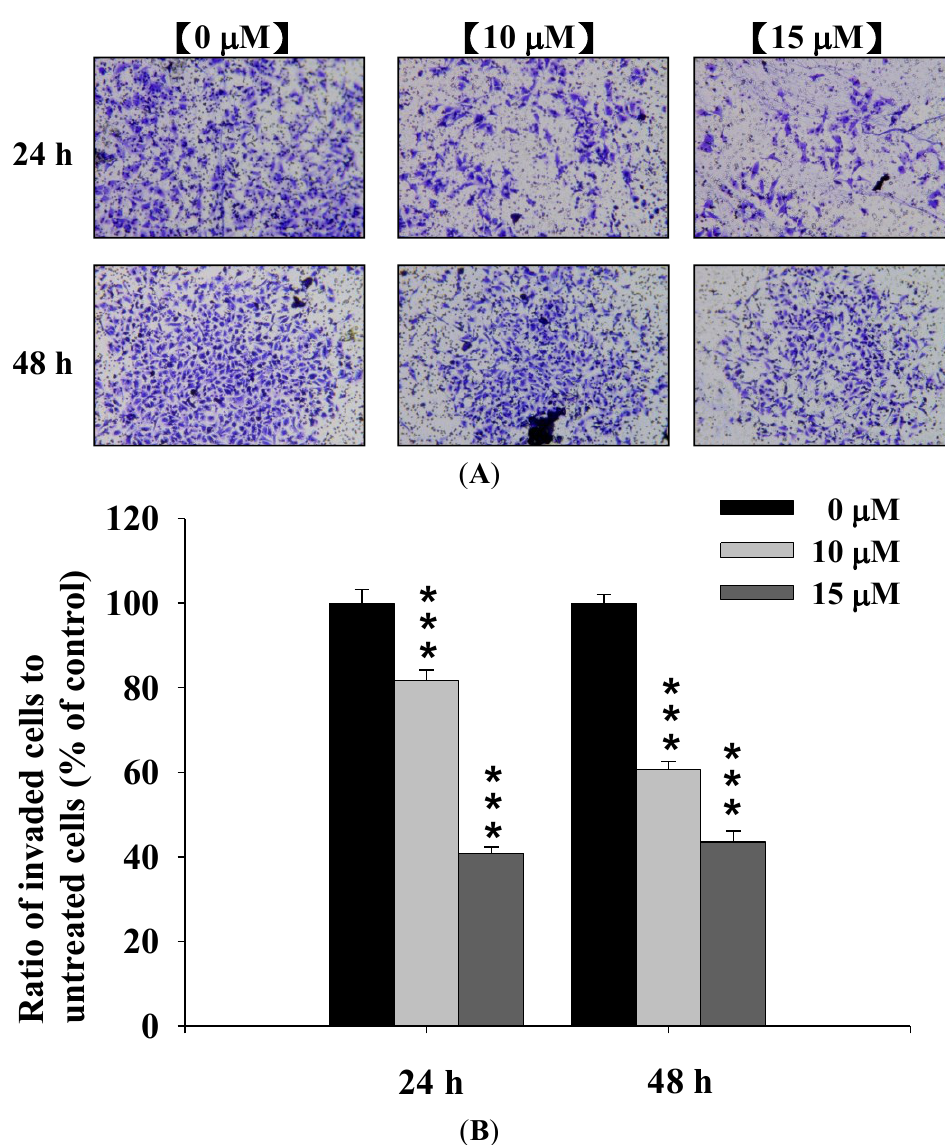
Figure 4. Deguelin suppressed the invasion of U-2 OS cells in vitro . U-2 OS cells (5 × 10 4 cells/well) were incubated with 0, 10 and 15 μM of deguelin then penetrated through with the matrigel to the lower surface of the filter were stained with crystal violet and were photographed under a light microscope at 200×. Quantification of cells in the lower chambers was performed by counting cells at 200×. *** p < 0.001, significant difference between deguelin-treated groups and untreated-groups as analyzed by Student’s t test. Cells were stained with crystal violet and then were examined and photographed under a light microscope at 200× ( A ); The quantification of cells from each treatment in the lower chambers was counted at 200× ( B ).